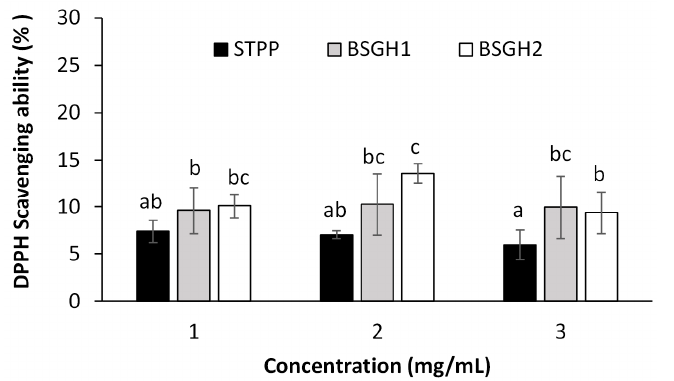
Figure 3. DPPH radical scavenging ability of BSGH1, BSGH2, and STPP at different concentrations. The values are expressed as the mean ± standard deviation of three replicates. Different letters indicate significant differences ( p ≤ 0.05).